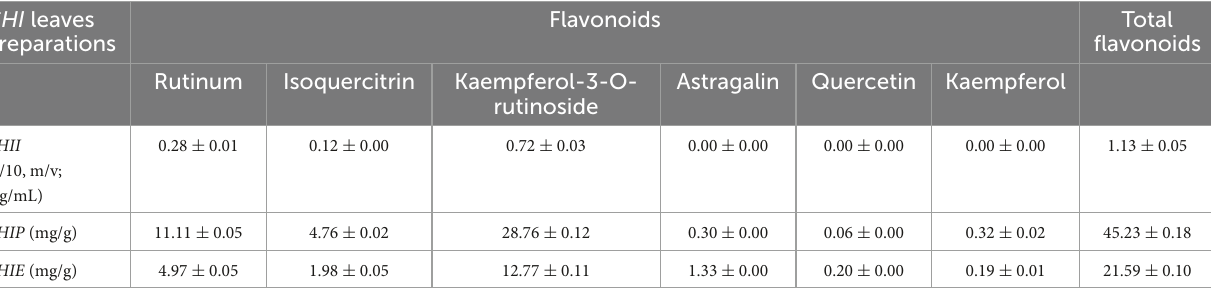
TABLE 1 Flavonoids content in CHI leaves preparations a . CHI leaves